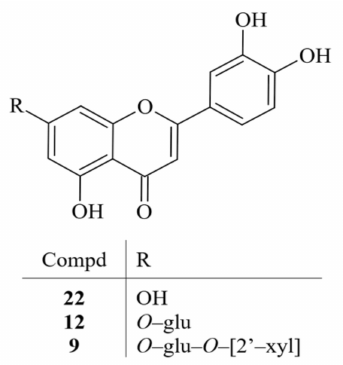
Figure 1. Chemical structures of isolated compounds 9 , 12 and 22